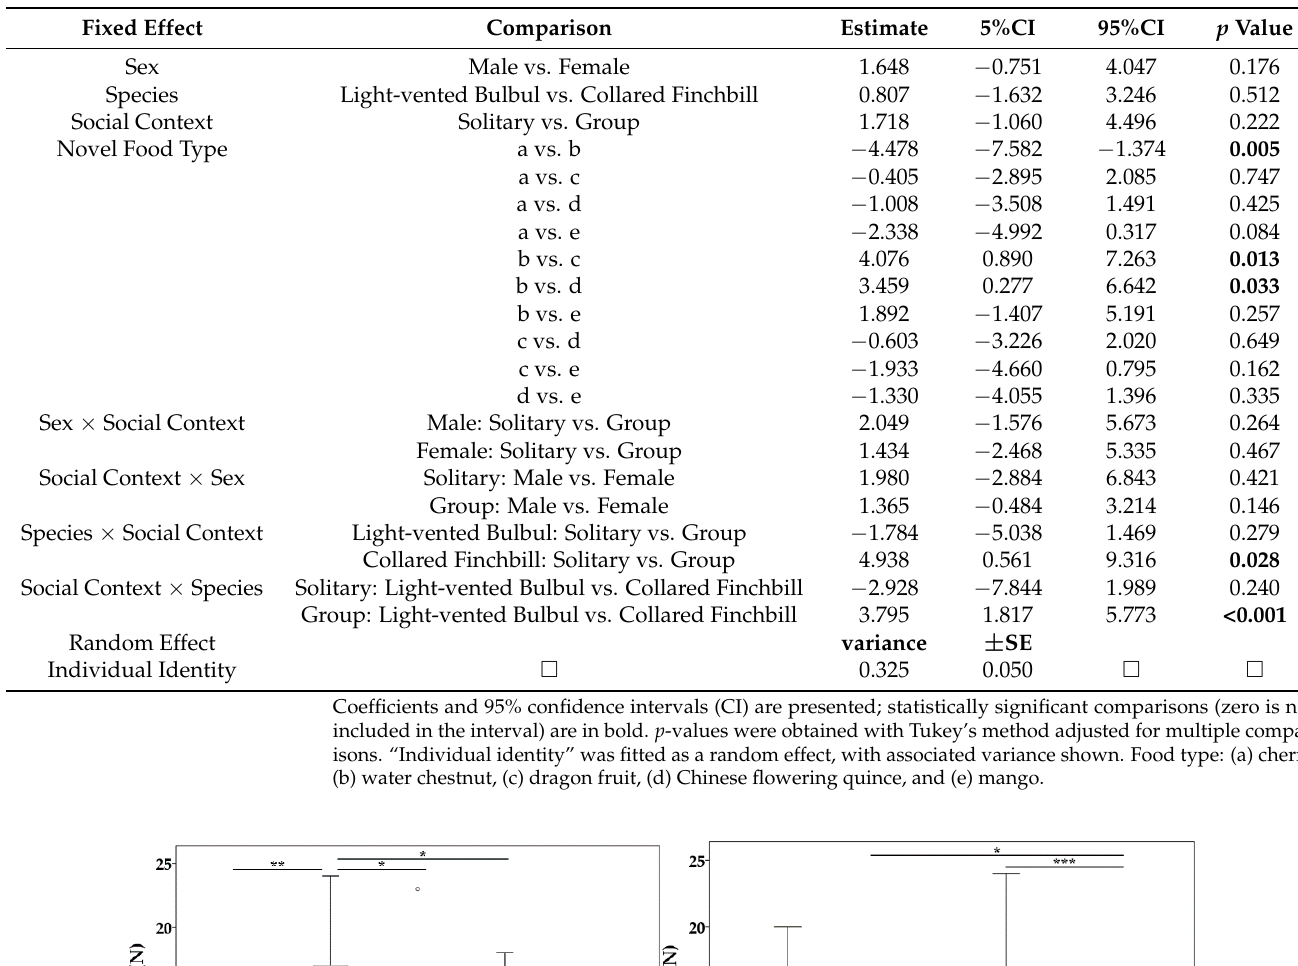
Table 1. Effects of fixed factors on foraging times (N) for solitary and group Light-vented Bulbuls and Collared Finchbills.